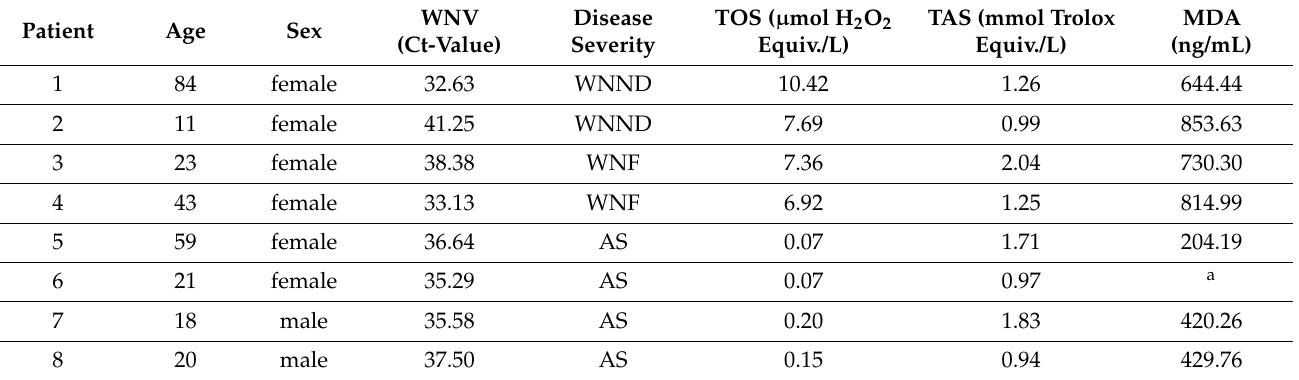
Table 1. Serum concentrations of markers of oxidative stress in 8 WNV-infected patients from Israel.